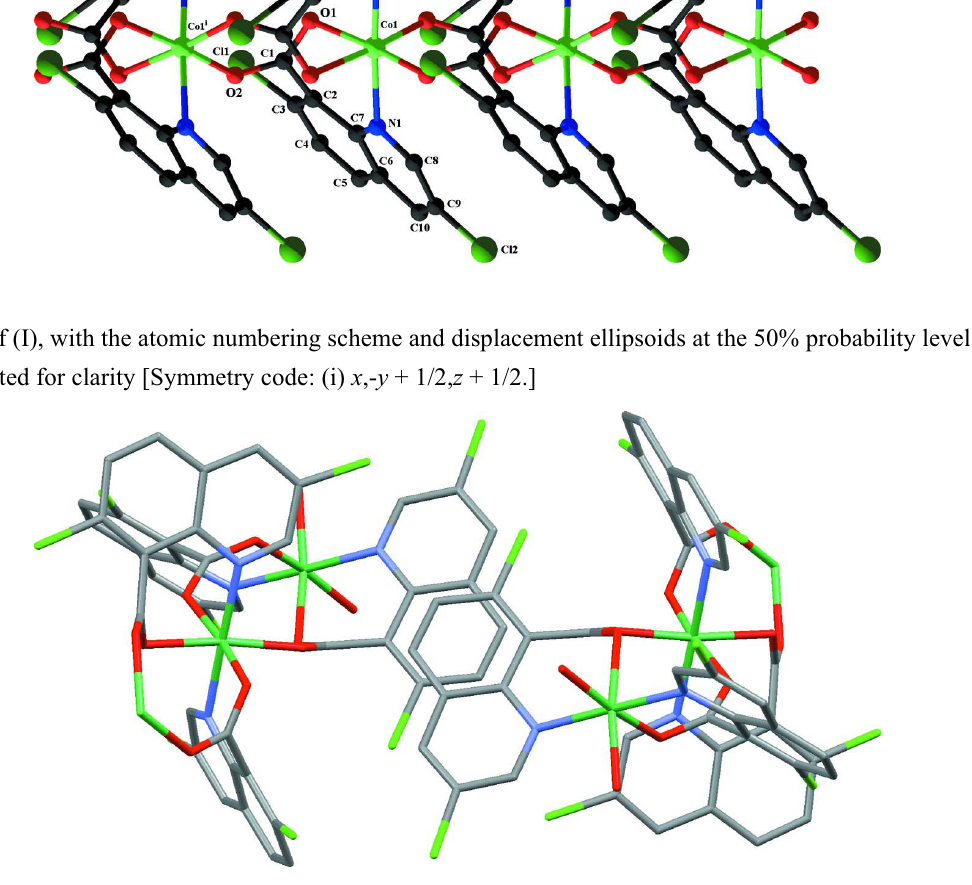
Figure 2 Three dimensional supramolecular architecture constructed by interchain π – π stacking interactions. catena -Poly[cobalt(II)-bis( µ -3,7-dichloroquinoline-8-carboxylato- κ 3 N , O : O ′ )] ? Crystal